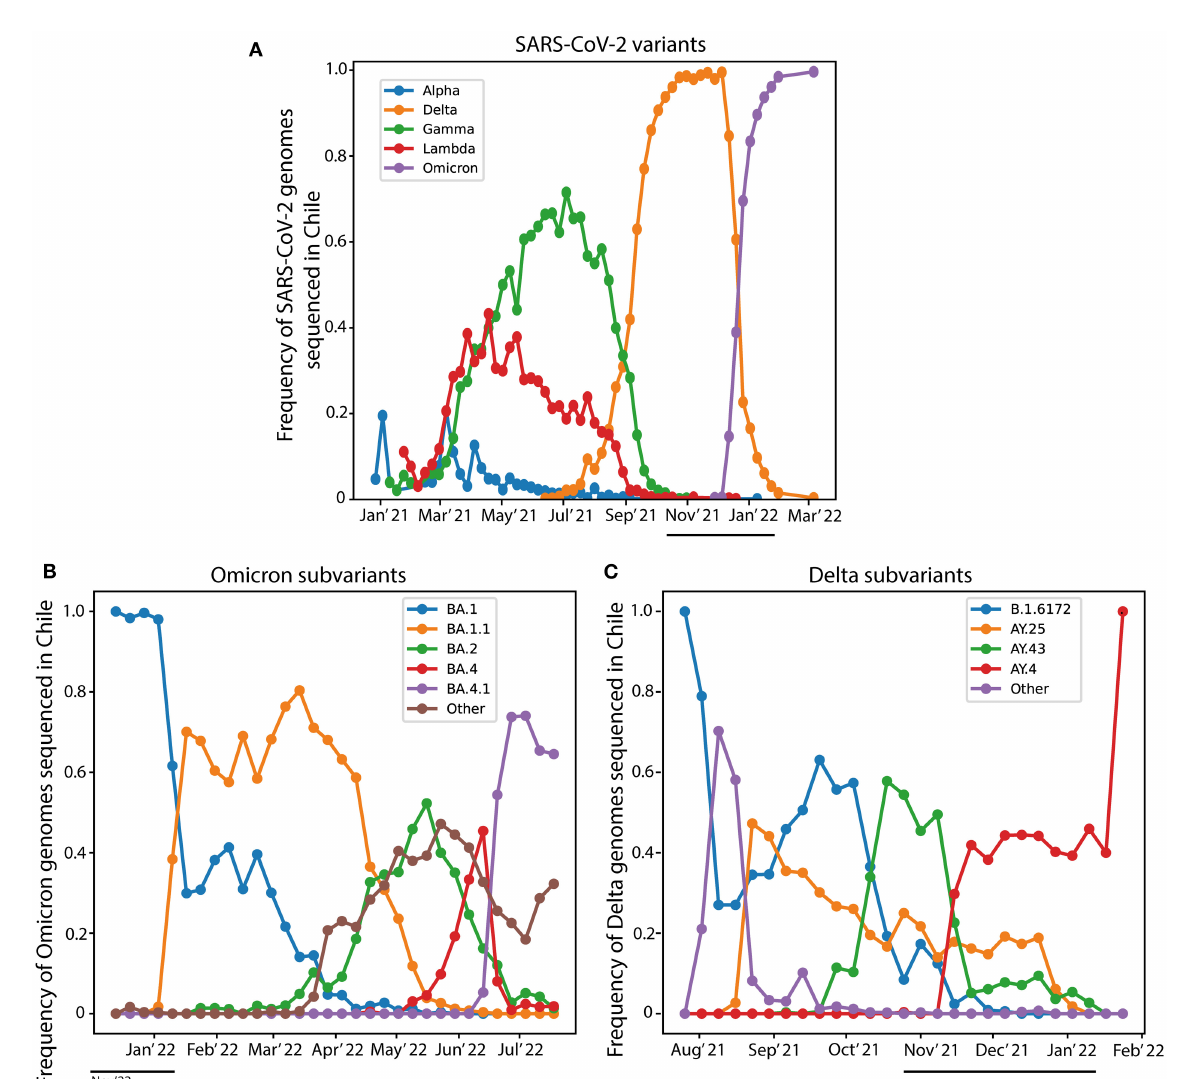
FIGURE1 Prevalence of SARS-CoV-2 variants in Chile. The frequency of SARS-CoV-2 genomes identified in Chile was obtained from the GISAID webpage. (A) The circulation frequency of the main variants of SARS-CoV-2 genomes data sequenced in Chile. (B) The circulation frequency of the Omicron subvariants sequenced in Chile. (C) The circulation frequency of the Delta subvariants sequenced in Chile. The black line shows the study period from November 2021 to January 2022. The data for the Omicron variant is available only since January 2022 in the GISAID